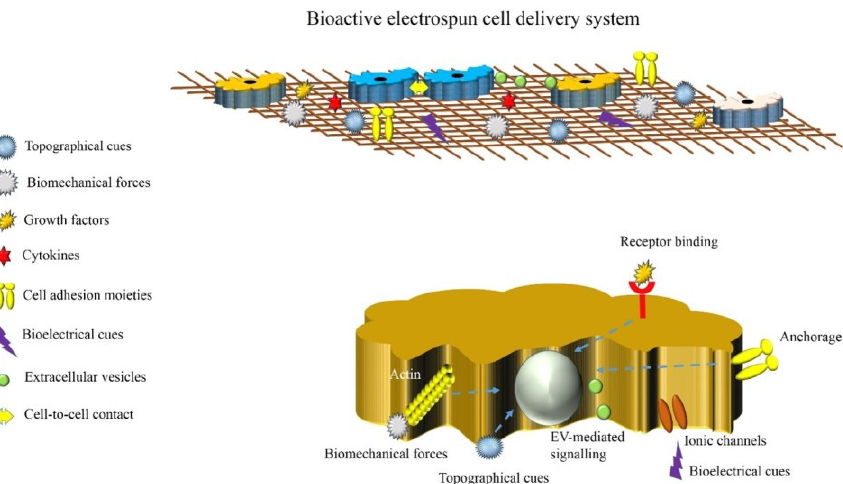
Figure 6. Schematic illustration representing the components of a bioactive electrospun cell delivery system. Cells bind to different niche components with surface receptors, thus activating the cell anchorage-dependent signaling pathways. Cells respond to topographical cues and biomechanical forces by altering their cytoskeleton and various signaling pathways. EVs derived from neighboring or distant cells are internalized into the seeded cells and mediate intercellular communications. Bioelectrical cues regulate cellular function by ionic flows from ionic channels. Growth factors and cytokines bind to cellular receptors and convey messages to the cytoplasm or nucleus by a diverse range of signaling pathways.